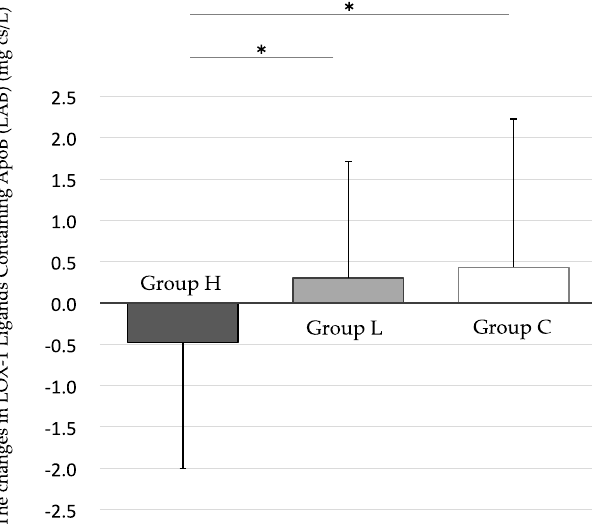
Figure 3. The changes in LOX-1 ligands containing ApoB (LAB) level from 0 to 12 weeks. The Steel–Dwass test shows significant differences in the ∆ value at 12 weeks between group H and group L, and between group H and group C. Data are shown as mean ± SD, * p < 0.05. Black bar: High-dose “Benifuuki” extract ice cream group (group H). Gray bar: Low-dose “Benifuuki” extract ice cream group (group L). White bar: No “Benifuuki” extract ice cream (control) group (group